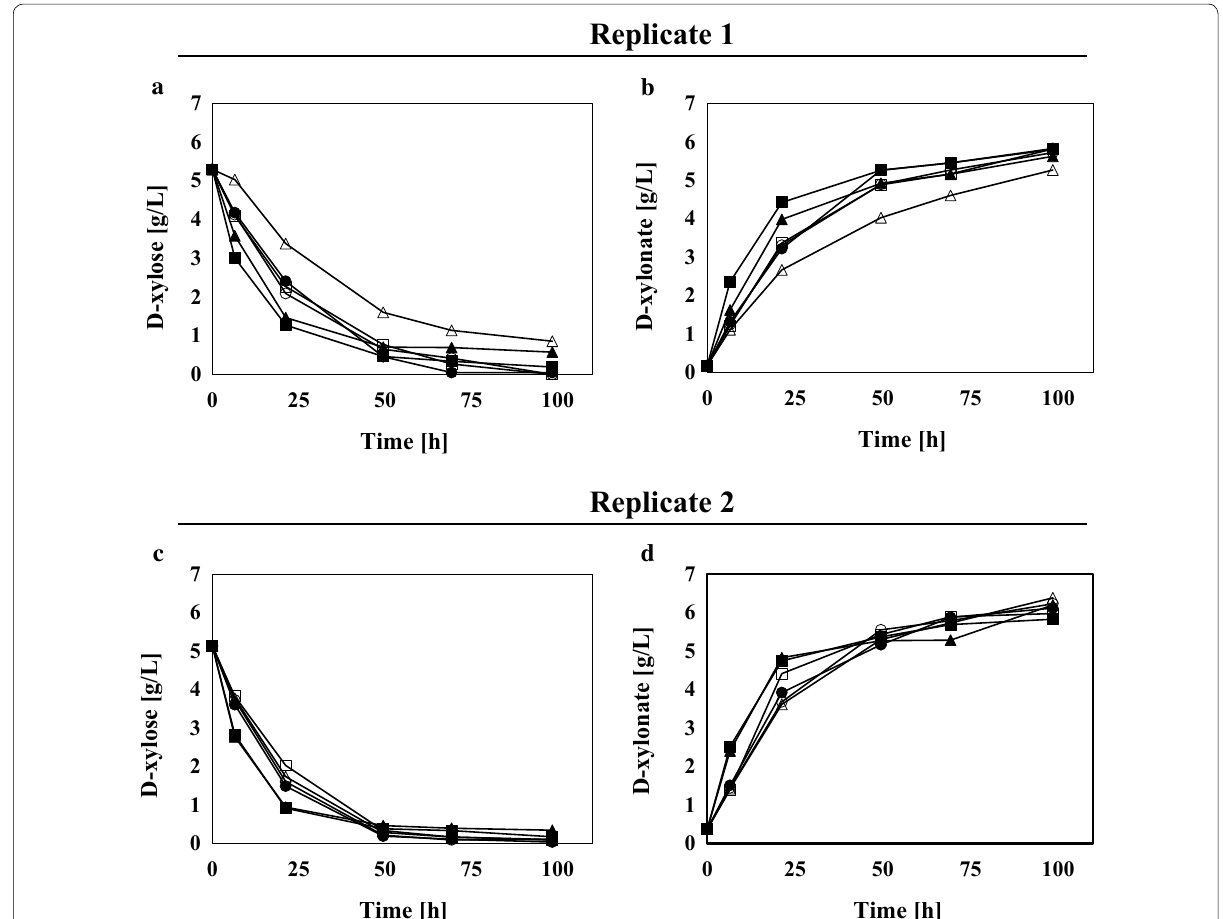
Fig. 5 Aerobic bioconversion of d ‑xylose into d ‑xylonate in recombinant Saccharomyces cerevisiae strains. TMB4511 ( xylB , xylC : filled square), TMB4512 ( xylB : filled triangle), TMB4530 ( xylB , xylD , xylX , xylA : filled circle), TMB4569 ( xylB , xylD_Bc , xylX , xylA : square), TMB4570 ( xylB , yjhG_Ec , xylX , xylA : triangle), TMB4571 ( xylB , xylD_El , xylX , xylA : circle). All experiments were performed in biological duplicates. The d ‑xylose consumption and d ‑xylonate formation in replicate 1 is shown in the upper a and b , respectively. The lower c and d show d ‑xylose consumption and d ‑xylonate formation in replicate 2, respectively